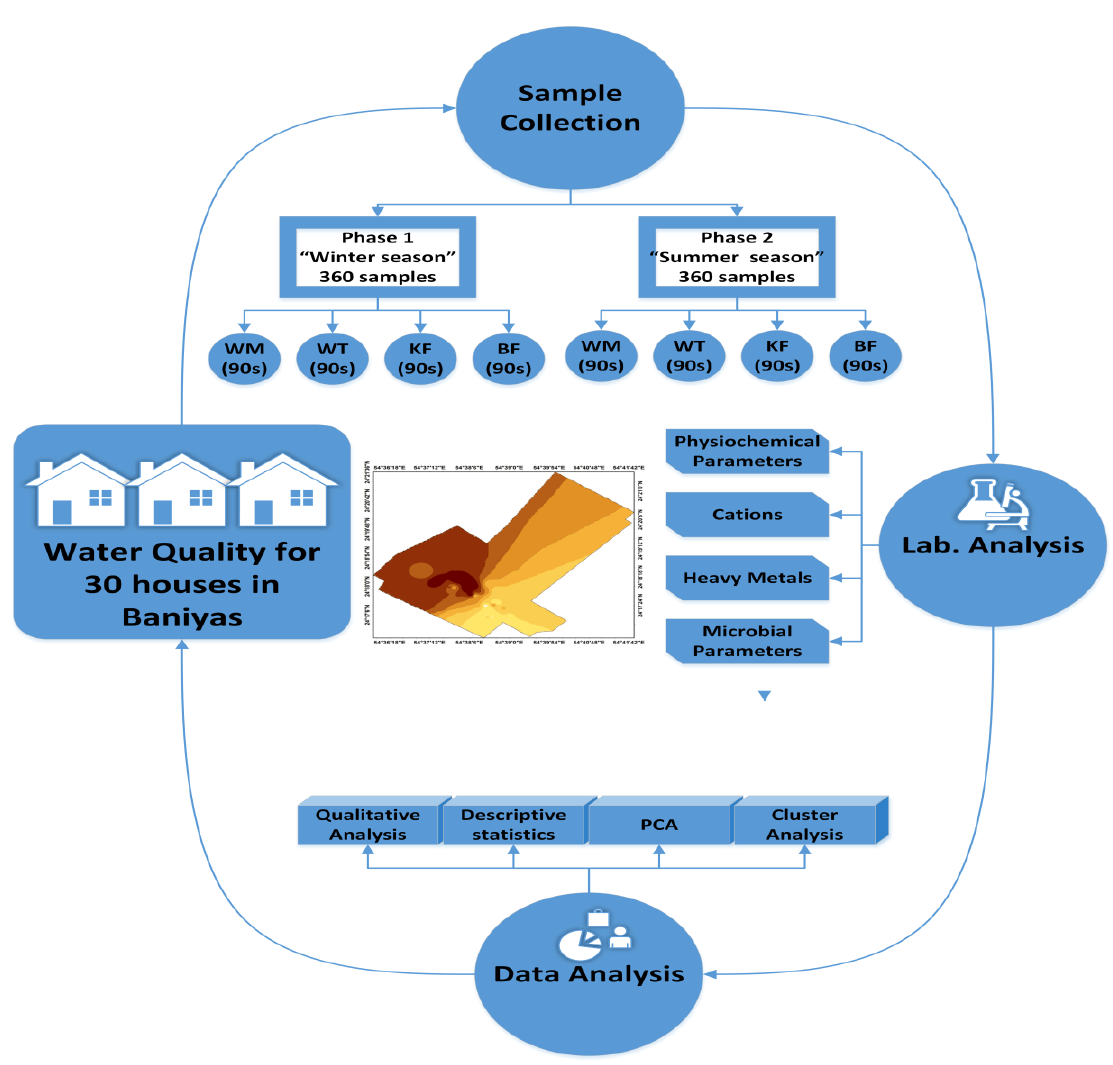
Figure 2. Summary of the methodology used in the study.